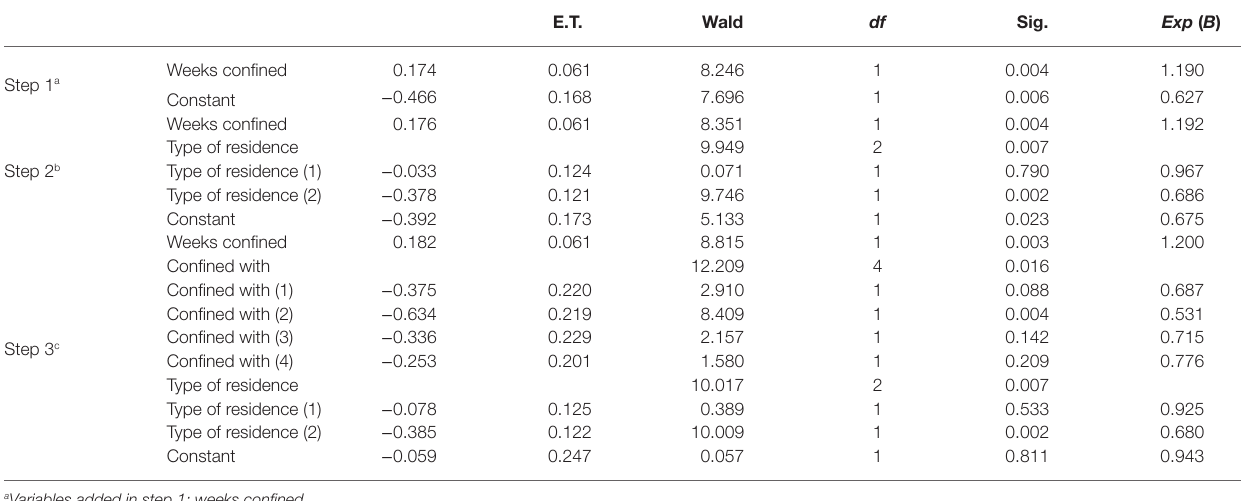
TABLE 6 | Variables in the equation.